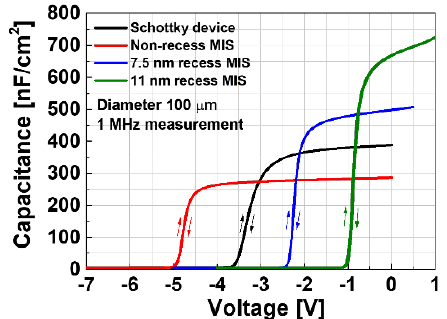
Figure 7. Gate capacitance-voltage characteristics of different gate structures in circular process control monitor patterns.